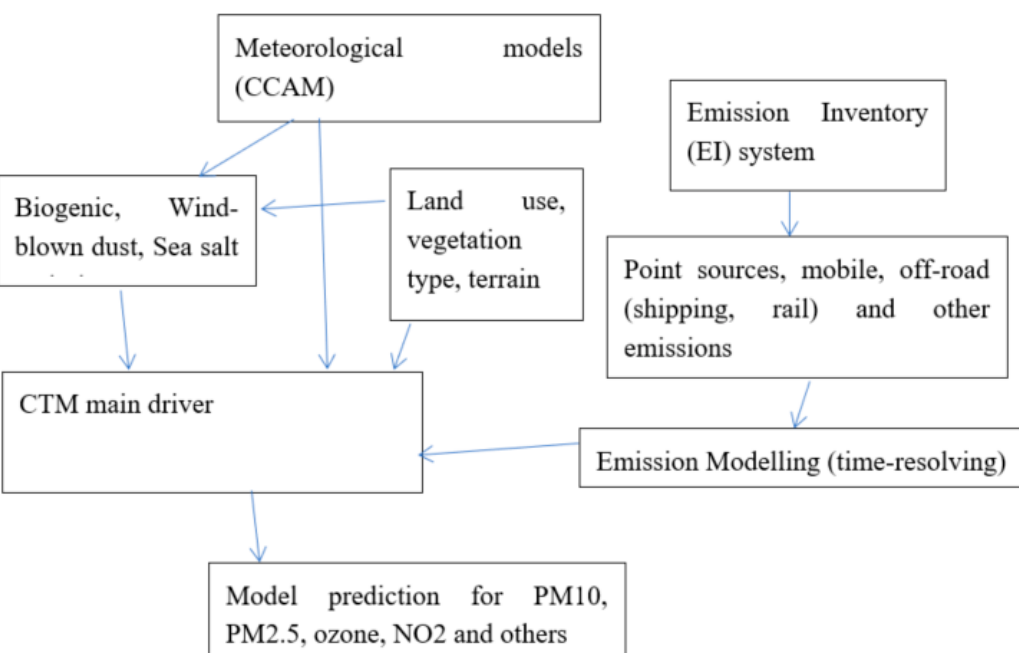
Figure 1. Schematic structure of the emission and chemical transport model (CTM) modelling system.